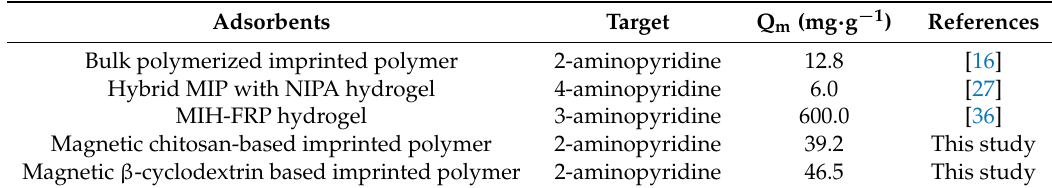
Table 2. Comparison of the maximum adsorption capacity of aminopyridine on prepared MMIPs with other reported adsorbents.